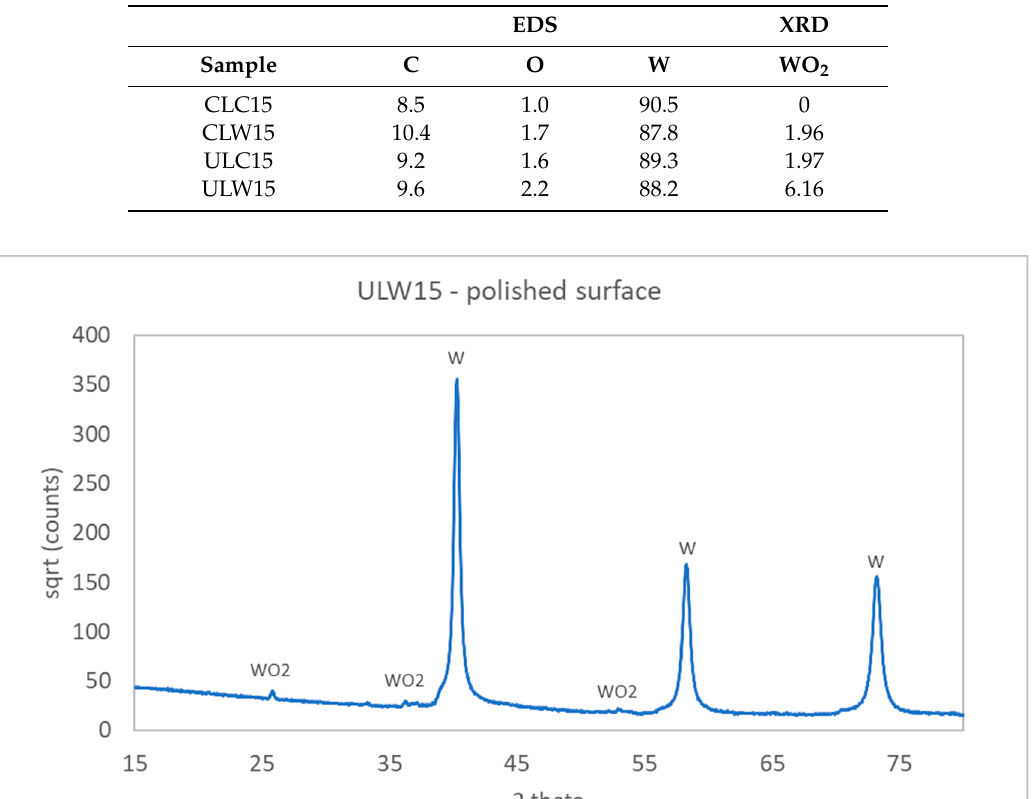
Figure 4. XRD pattern from a polished surface of the ULW15 sample. The most prominent peaks of the W and WO 2 phases are labeled.